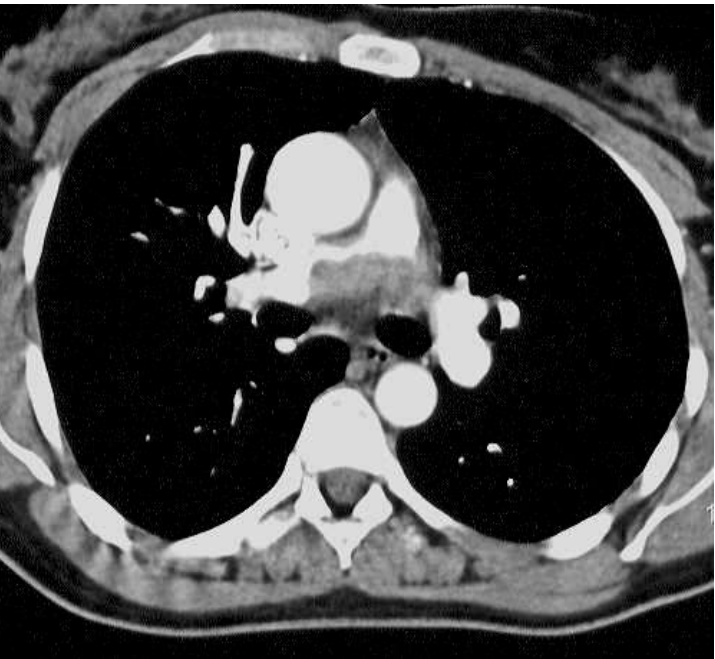
Figure 1. In case 3, CT shows a soft tissue lesion of lobed contours discretely heterogeneously attached to the median wall of the right pulmonary artery, obliterating more than 50% of its